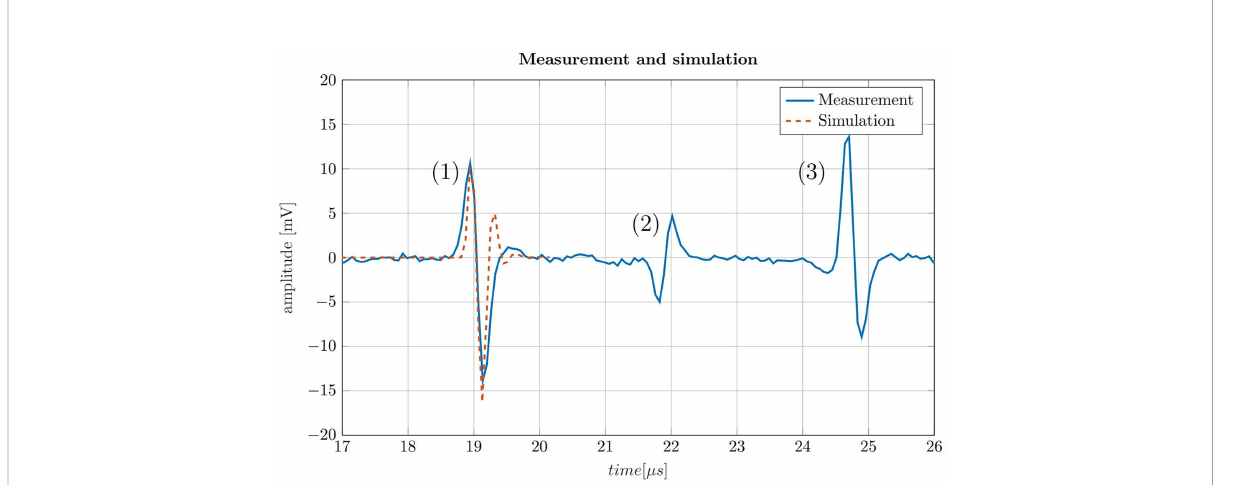
FIGURE 5 200-fold averaged ionoacoustic signal generated by a 160 ns rectangular pulse with a beam current of 4.5 m A and a total integral dose of 128 Gy plotted by the solid blue line. The signal is comprised of (1) the direct signal (2), the window signal and (3) an echo. Additionally a comparison with a simulation is shown for the direct signal by the dashed line, which was scaled to match the amplitude of the